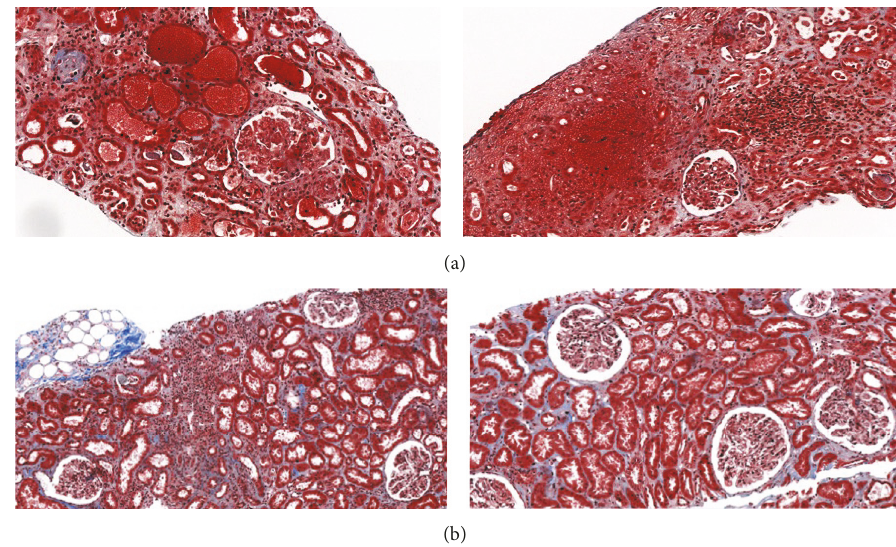
Figure 3: (a) Kidney allograft biopsy at postoperative day 12 in patient 2: thrombotic microangiopathy lesions, antibody-mediated rejection (t0, i0, g3, and cpt2). (b) Kidney allograft biopsy at postoperative day 54 in patient 2. Lesions of mixed acute cellular and antibody-mediates rejection (i2 i2 ti2 g2 cpt2), IF/TA 1, and no more lesions of thrombotic